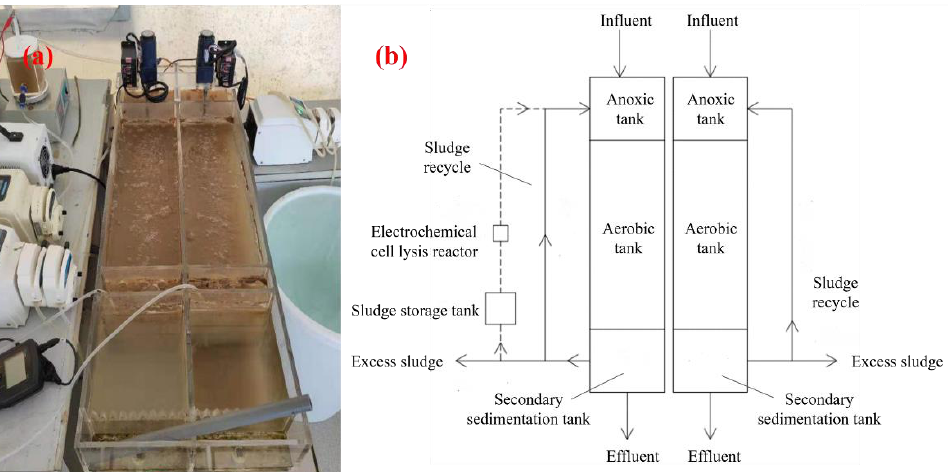
Figure 1. Electrochemical-A/O combined process device diagram: ( a ) physical diagram; ( b ) schematic diagram.